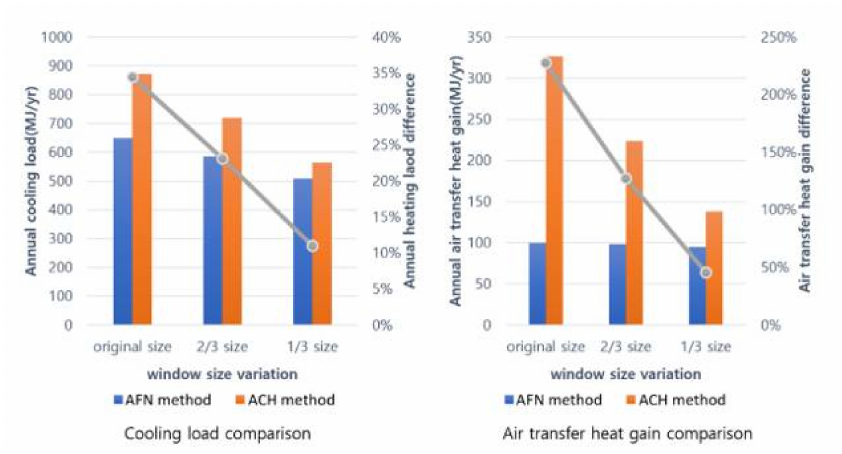
Figure 13. Comparison of the AFN model and the ACH model for annual cooling load and heat gained by air transfer in parametric analysis